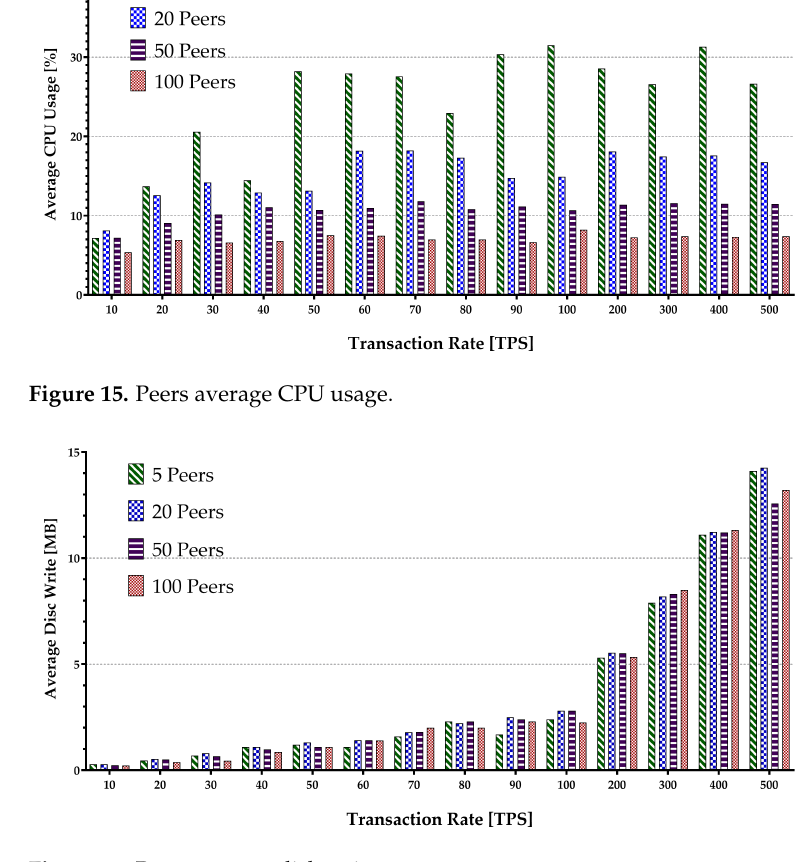
Figure 16. Peers average disk write